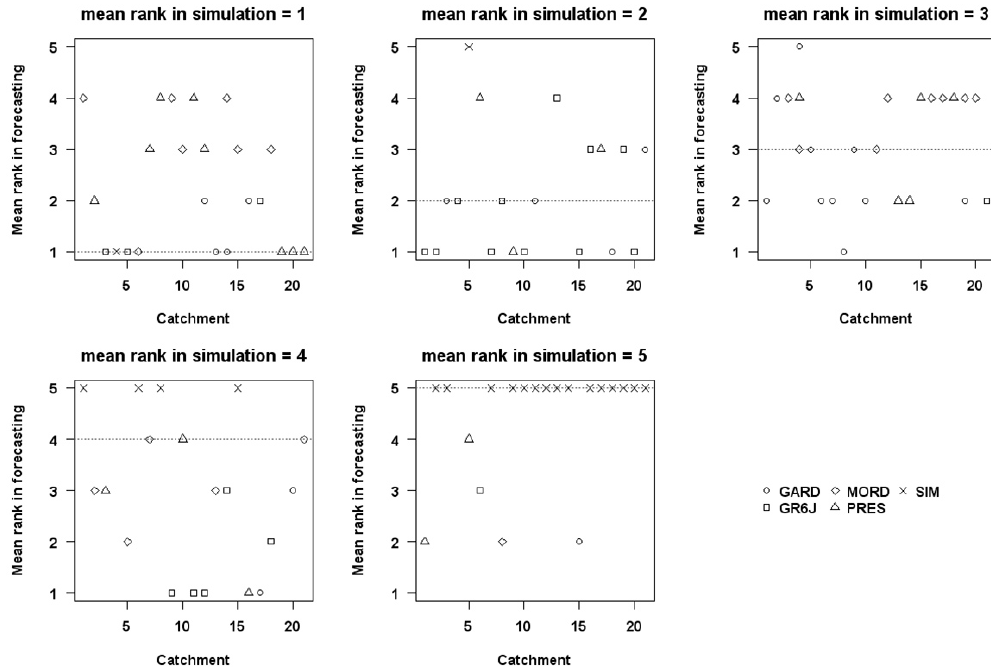
Figure 12. Mean model ranks for the 7 day forecast for the 21 catchments for the models ranked 1st, 2nd, ... 5th in simulation.